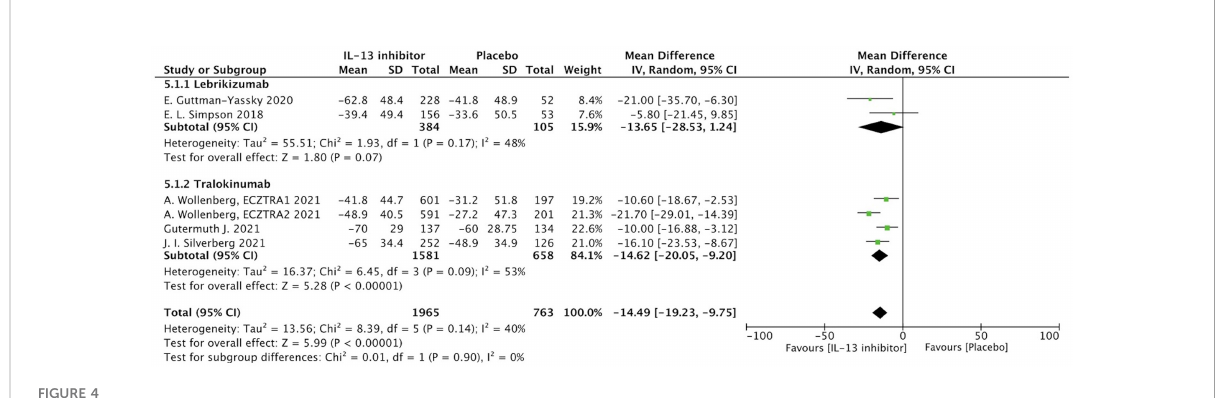
FIGURE 4 Forest plot for the improvement of DLQI at the end of antagonizing IL-13 treatment.